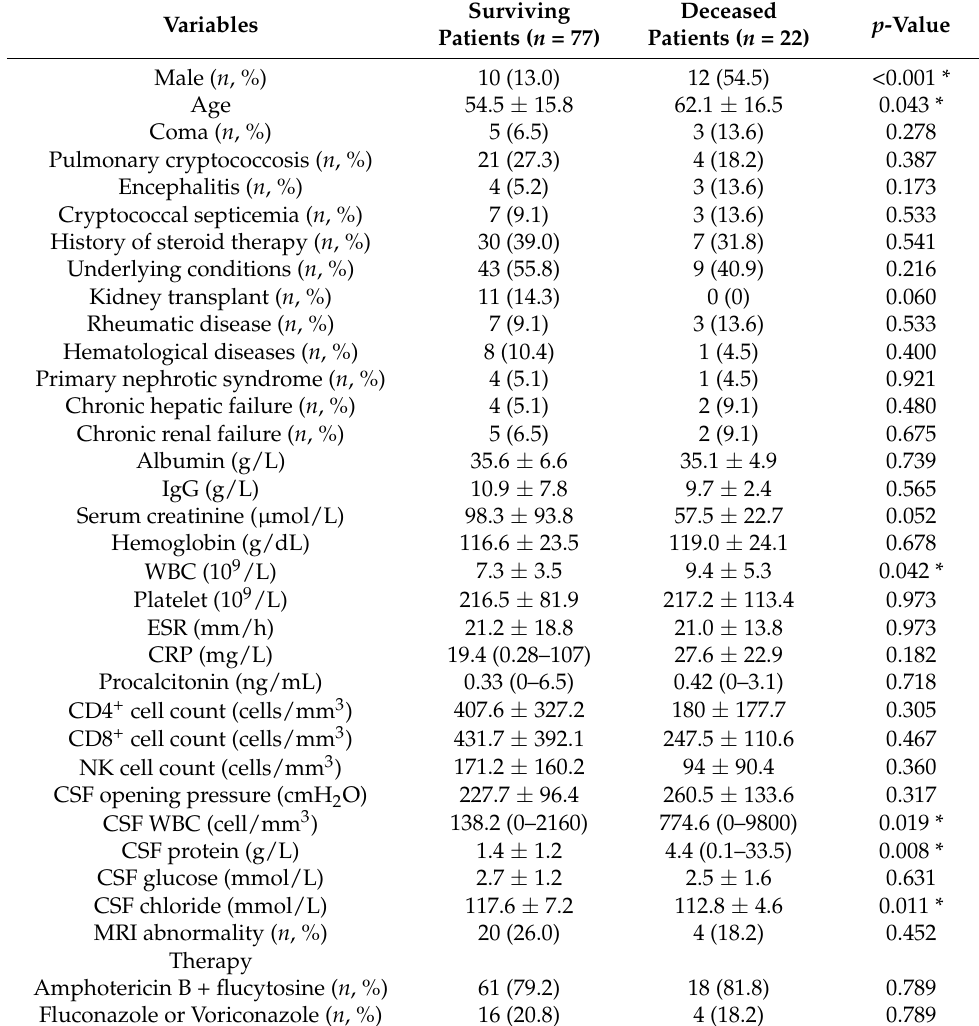
Table 4. Possible risk factors associated with mortality between surviving CM patients and deceased CM patients ( n = 99).